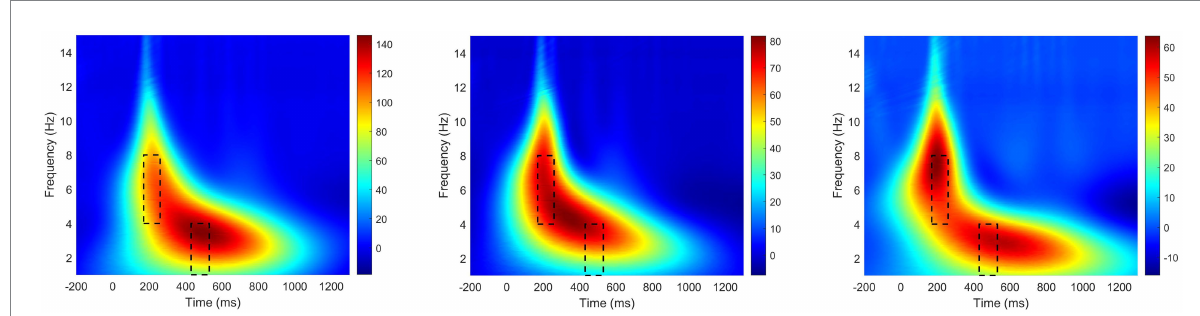
FIGURE 5 Time-frequency representations in the condition of LM, NM, and LE averaged over